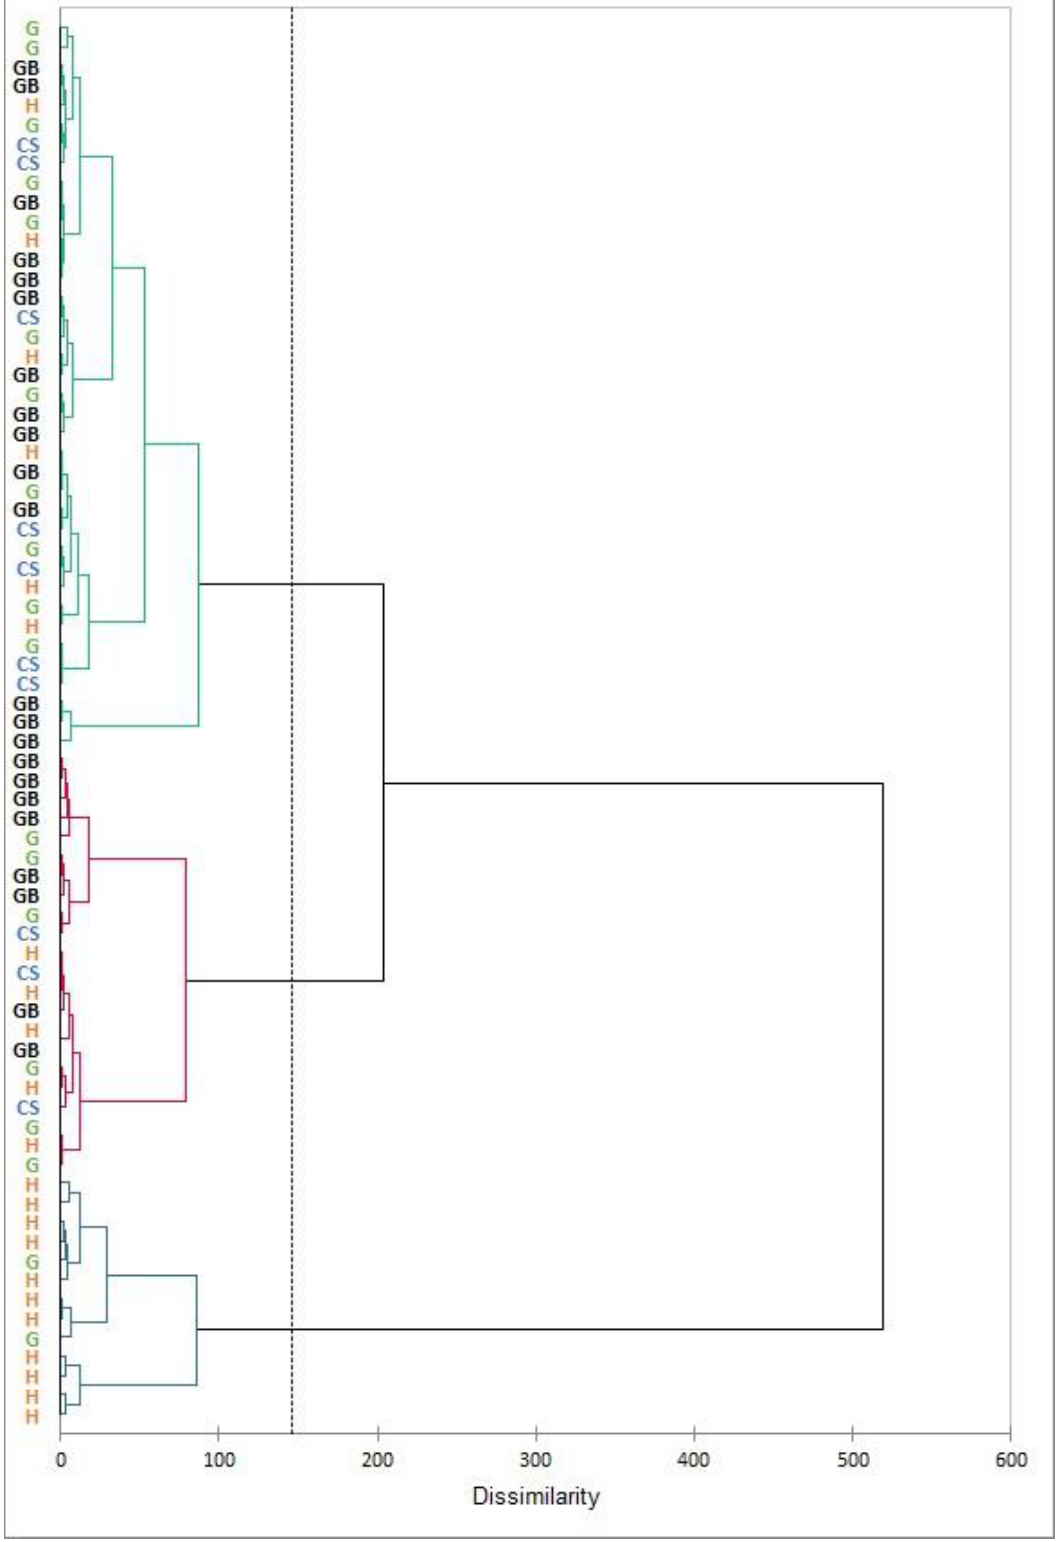
Figure 3. Dendrogram from hierarchical clustering analysis of the body composition data (CS: cuerda seca ; GB: green and brown decoration on white glaze; G: green glaze; H: yellow/honey glaze).